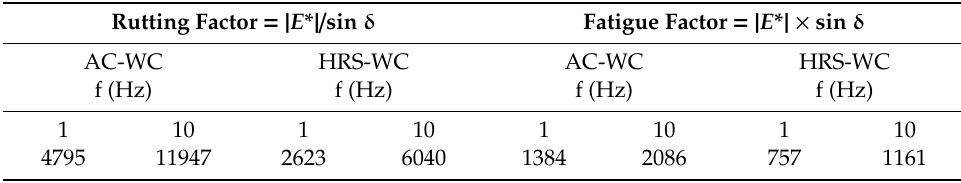
Table 6. Rutting and fatigue factors of AC-WC and HRS-WC mixtures at a reference temperature of 25 ◦